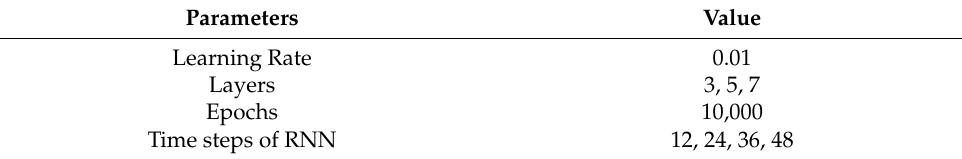
Table 2. Training Model